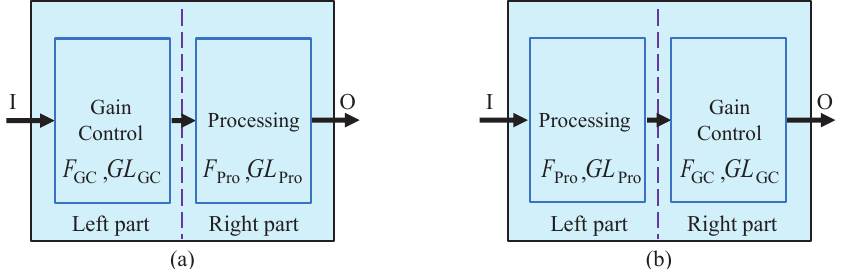
Figure 6. Basic unit models that constitute the gain control strategy. ( a ) Gain control is before the processing portion. ( b ) Gain control is after the processing